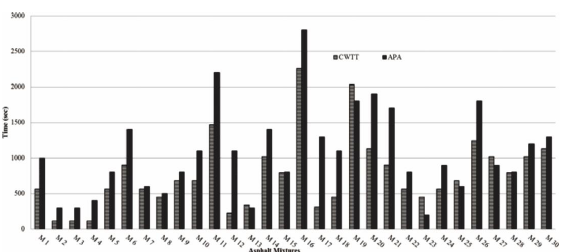
FIG. 11. PREDICTED VS. ACTUAL RUT DEPTH PLOT FOR APA